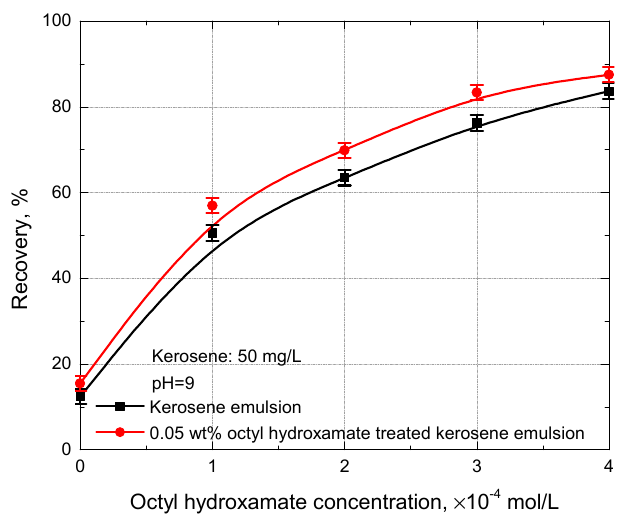
Figure 2. Flotation recovery of malachite with the addition of two kinds of kerosene emulsions as a function of octyl hydroxamate concentration.